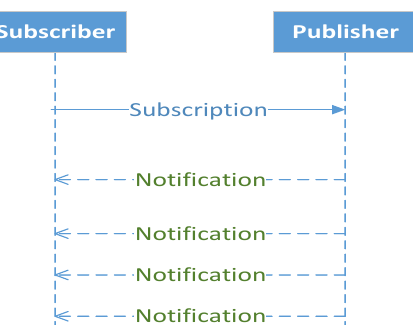
Figure 3. Observer Design